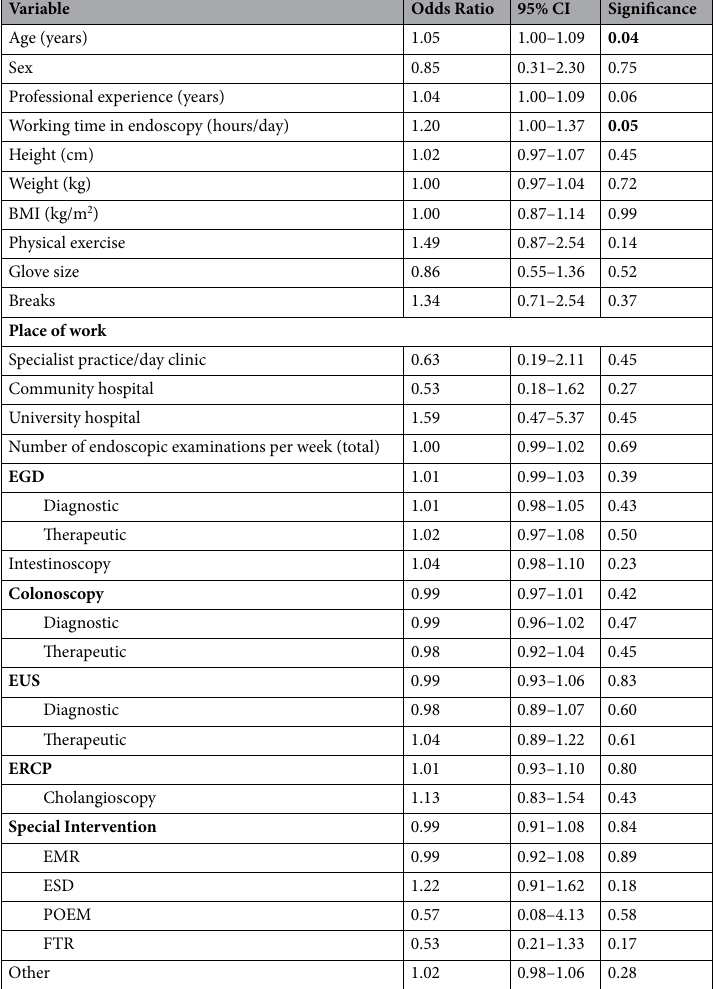
Table 5. Logistic regression model of predictors of endoscopy-associated musculoskeletal problems. EGD Oesophagogastroduodenoscopy, ERCP endoscopic retrograde cholangiopancreatography, EUS endoscopic ultrasound, ESD endoscopic submucosal dissection, EMR endoscopic mucosal resection, POEM peroral endoscopic myotomy, FTR full-thickness resection, BMI body mass